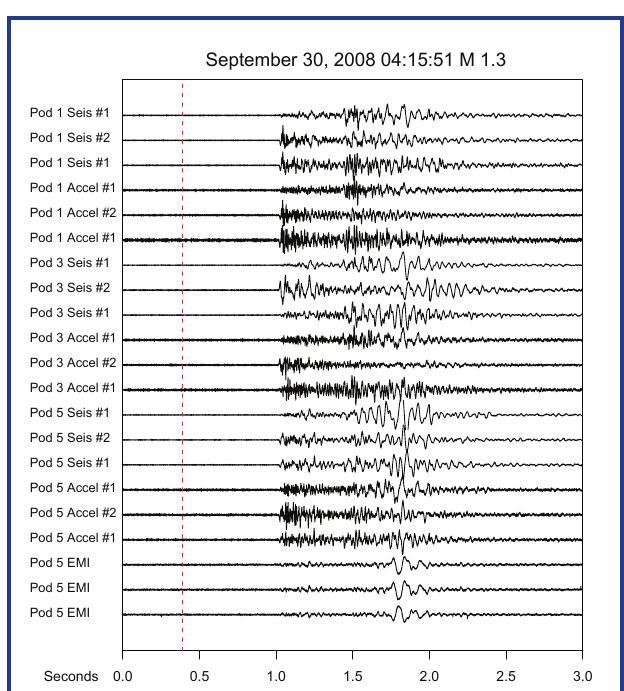
Figure 8. Seismograms from an M 1.3 microearthquake on 30 September 2008 recorded on the SAFOD observatory. The origin time of the microearthquake is shown by the dashed red line. The lower three traces are the output of the passive electromagnetic